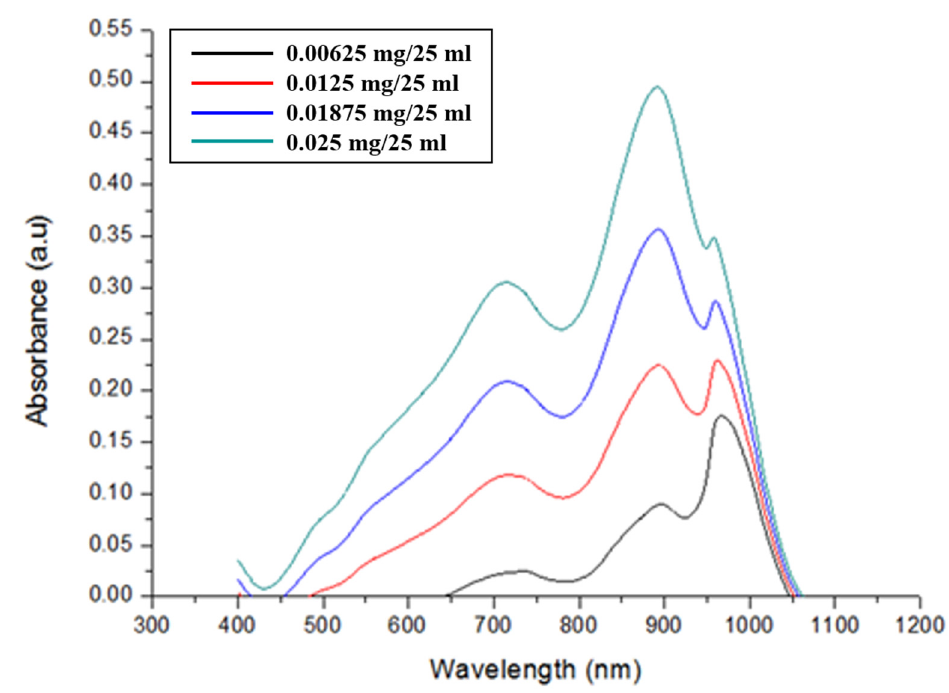
Figure 6. Measured absorbance of standard phosphate solution along with various phosphate concentrations.